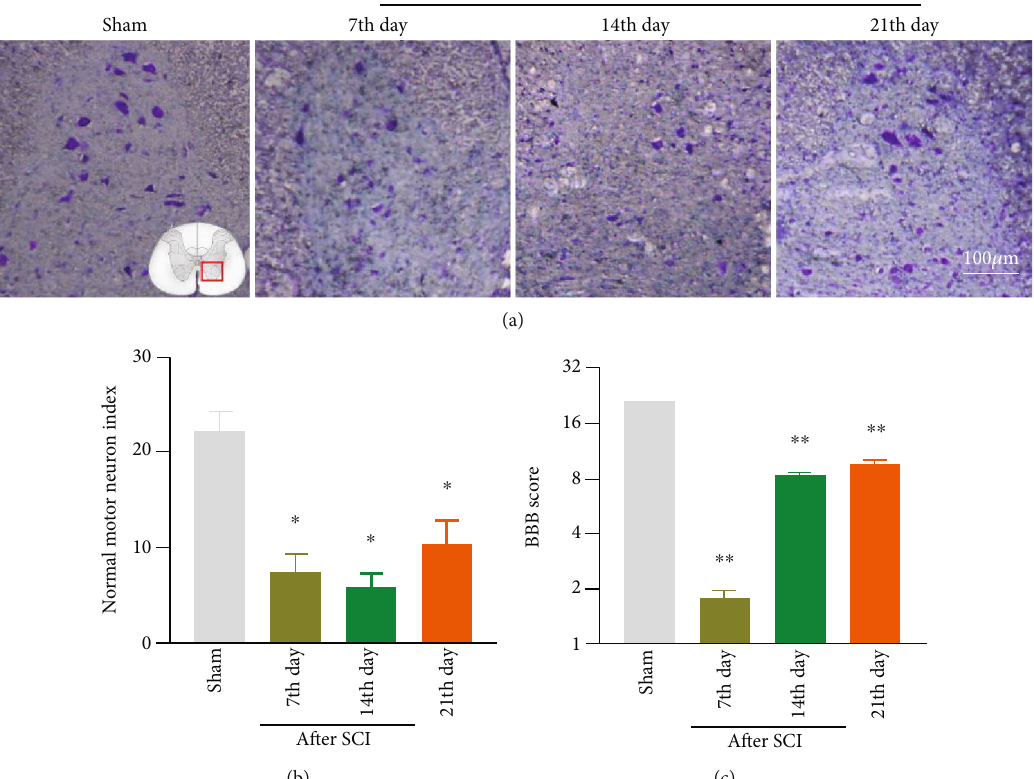
Figure 2: Establishment of the SCI model in rat. After SCI, the motor neurons in the ventral horn of the spinal cord decreased, the Nissl ’ s body became fuzzy, and the motor function decreased. (a) The Nissl staining of the ventral horn of the spinal cord in the sham group and the SCI group represents the fi gure. (b) The number of surviving motoneurons in the ventral horn of the spinal cord was quanti fi ed, n = 3 . (c) BBB function scores of rats in the sham group and the SCI group, n = 10 , compared with the sham group, ∗ P < 0 : 05 , ∗∗ P < 0 : 01 . All data are presented as the mean ± SEM